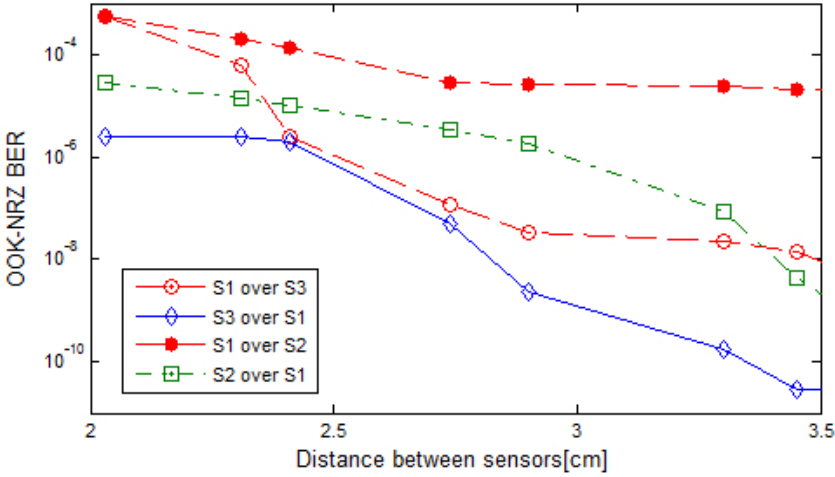
Figure 21. Normalized Power Signal to Interference Ratio (NPSIR) projection Simulation. Bite Error Rate in function of the separation between sensors. The sensors transmitted OOK-NRZ signals in Red (S1), Green (S2) and Blue